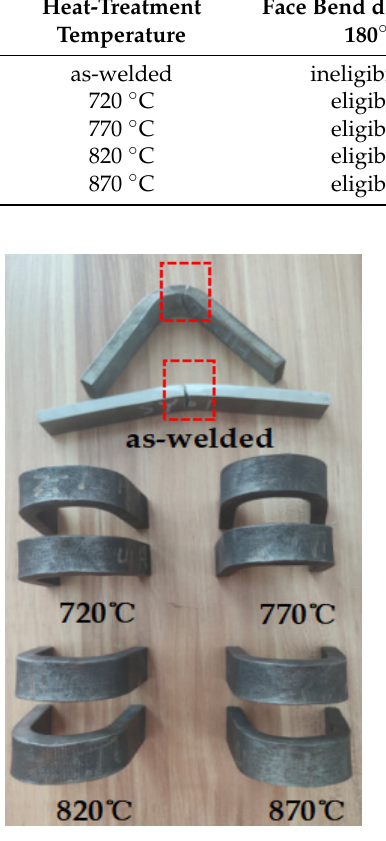
Figure 24. Bending result diagram